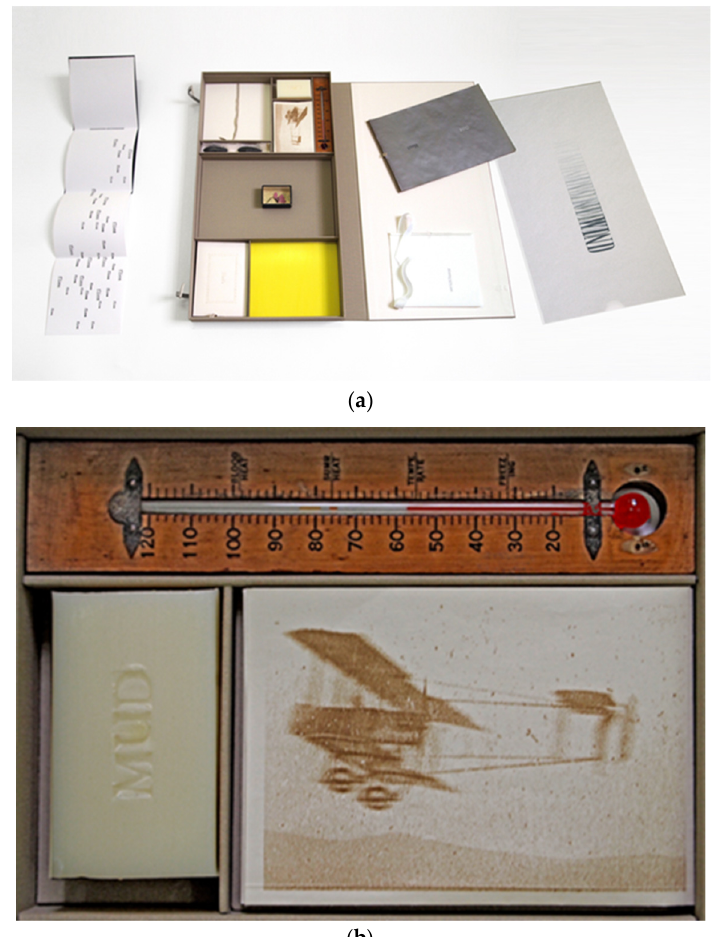
Figure 1. ( a ) Wilson, S. Discomforts , 2018. Letterpress, plate lithography on paper, soap, newsprint, Shoji paper with mixed media objects, Edition 1 of 2. (Photo: Paul Keir). ( b ) Wilson, S. Discomforts (Detail) Imprinted soap, thermometer, photolithographic print (Photo: Paul Keir).